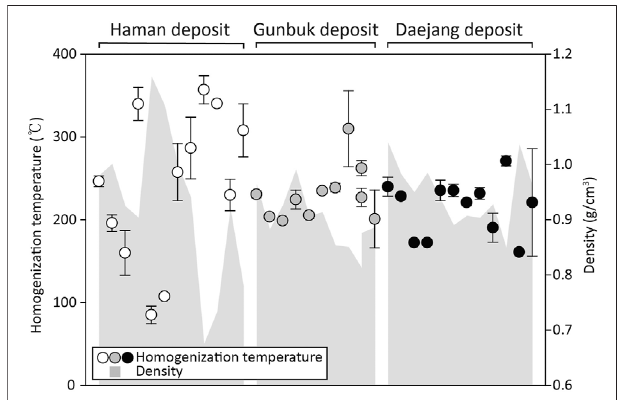
FIGURE 10 | Homogenization temperature and density plots of liquid inclusion assemblages. The Gunubuk and Daejang deposits have similar densities and temperature ranges, whereas the Haman deposit has broader and higher average ranges.